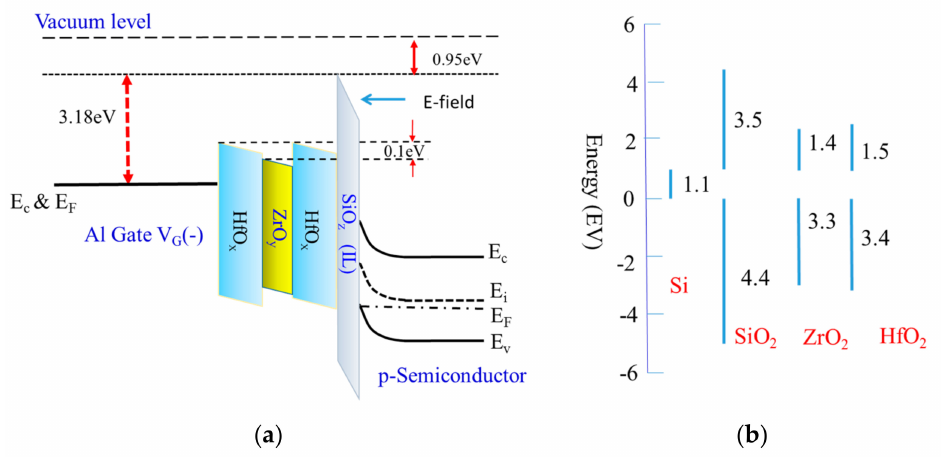
Figure 10. ( a ) Simple band diagram of high-k (HK)-stacked HfO x / ZrO y / HfO z (HZH) structure operated at accumulation mode. E C : Conduction band, E i : Intrinsic Fermi level, E F : Fermi level, and E V : Valence band, and ( b ) band o ff set for di ff erent dielectric compared with